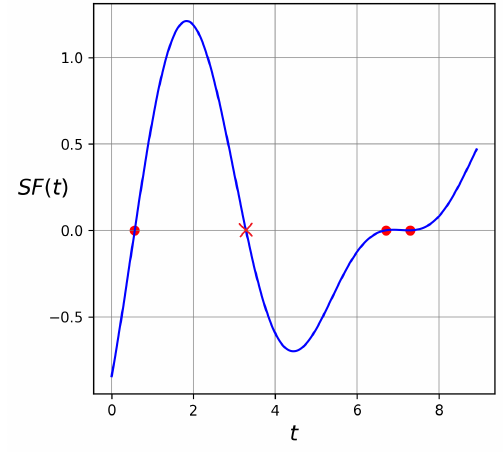
Figure 2. Switching function SF ( t ) for ε = 0.599.